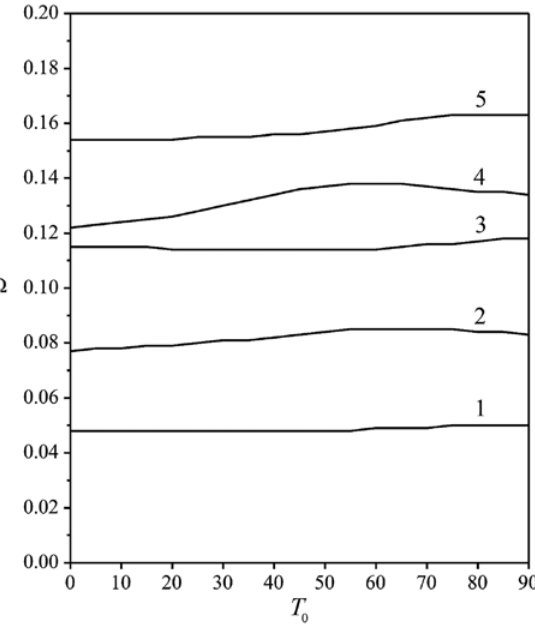
= 30 ° ) for the first five ( T 0 1